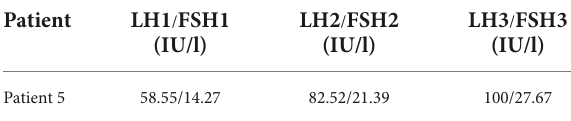
TABLE 3 Gonadotropin-releasing hormone stimulation result of the patient